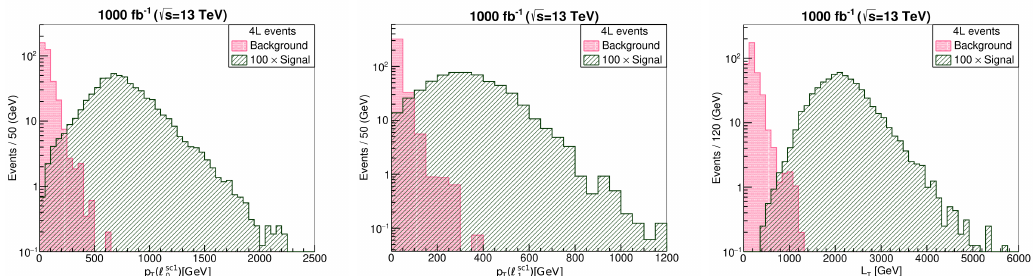
Figure 6 . Kinematic distributions for 4L events for BP1 . Left (middle): the p T -distributions of the leading (subleading) positive-charge lepton. Right: the L T distribution. The events are weighted at 1000 fb − 1 luminosity at the 13 TeV